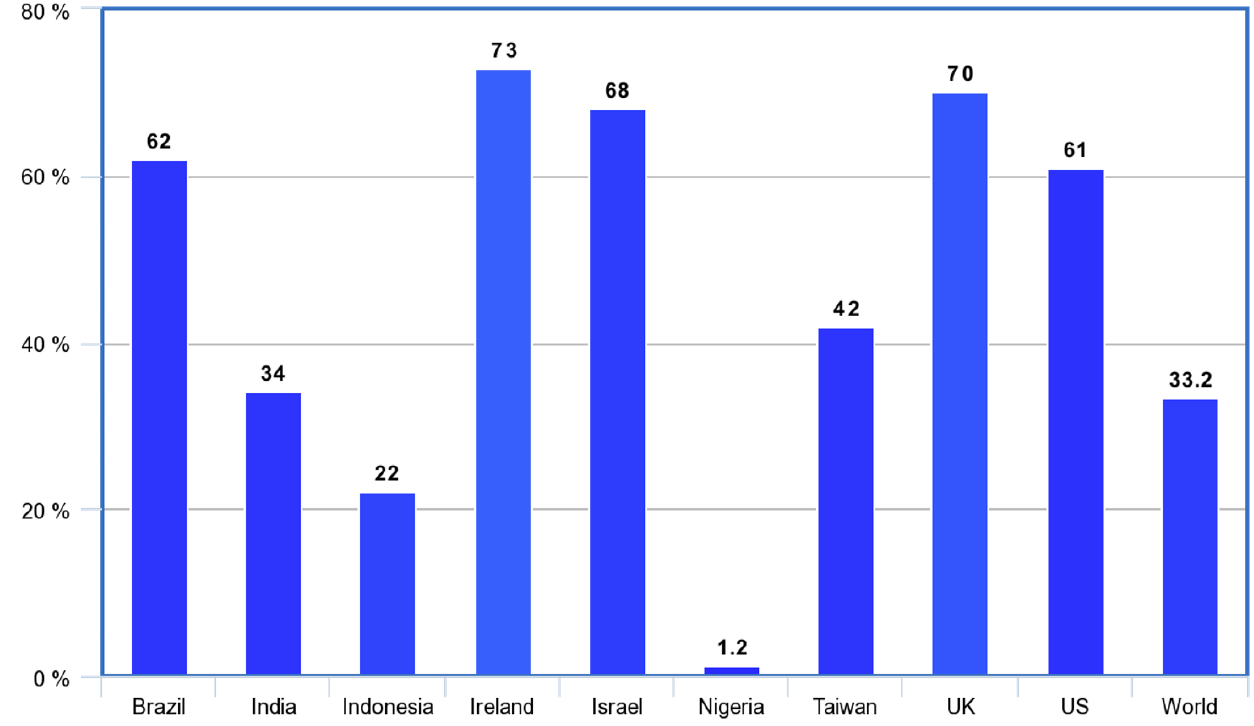
Figure A1. Percentage of population to receive at least one COVID ‐ 19 vaccine dose: 28 August 2021 [1].